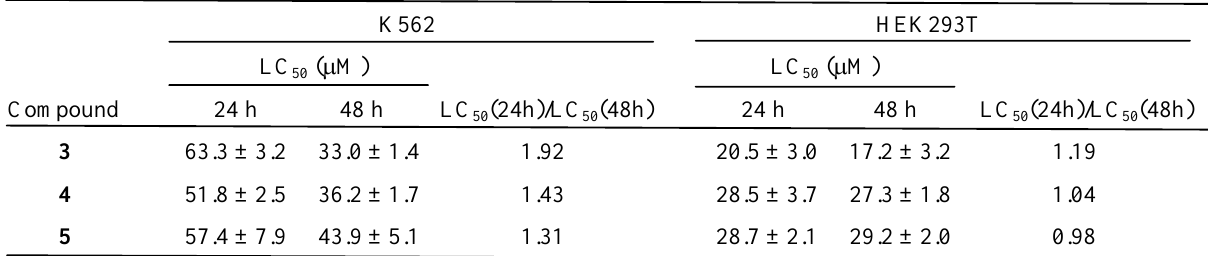
Table 1. Cytotoxic activities of compound 3 - 5 on cultured